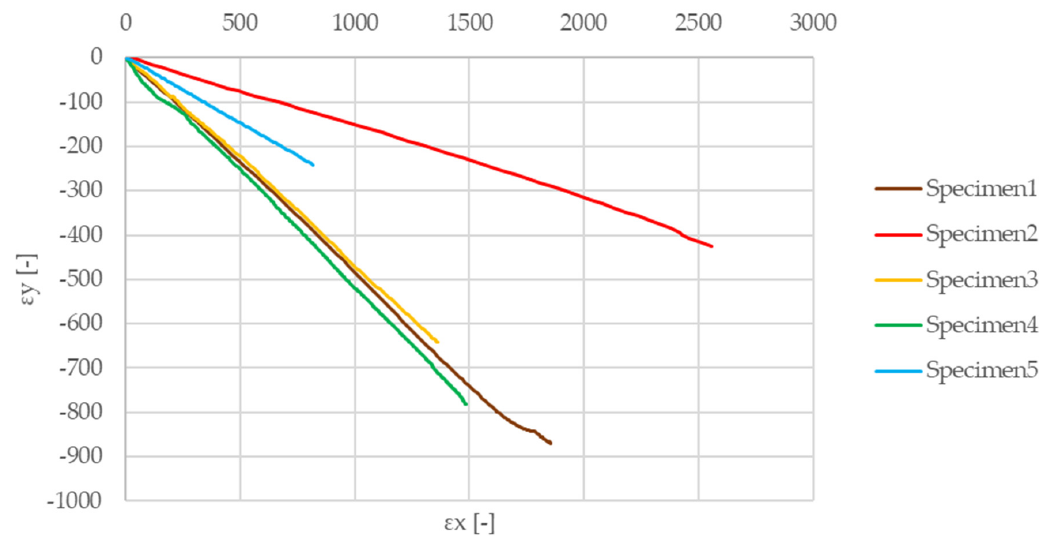
Figure 13. Poisson coefficient measurement via two directional strain-detection.